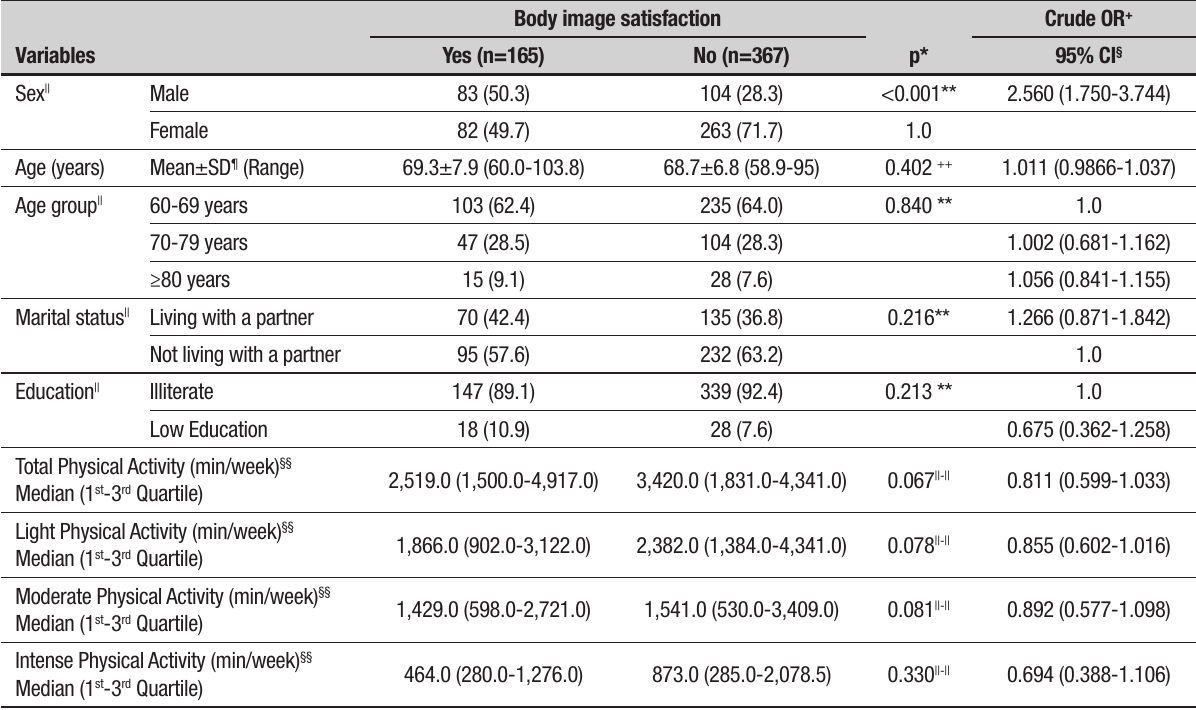
Table 2. Sociodemographic characteristics and physical activity of sample, according to body image satisfaction.